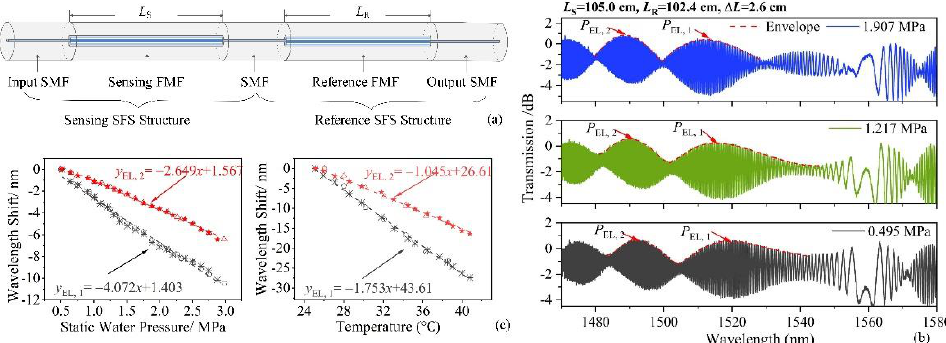
Figure 5. ( a ) Diagram of the cascaded SMF – FMF-SMF(SFS) structure; ( b ) experimental transmission spectra of the cascaded SFS structure under static water pressure variations; ( c ) wavelength shifts in PE L. 1 and PE L. 2 under static water pressure and temperature variations. @ (2020) IEEE. Reprinted, with permission, from [11]